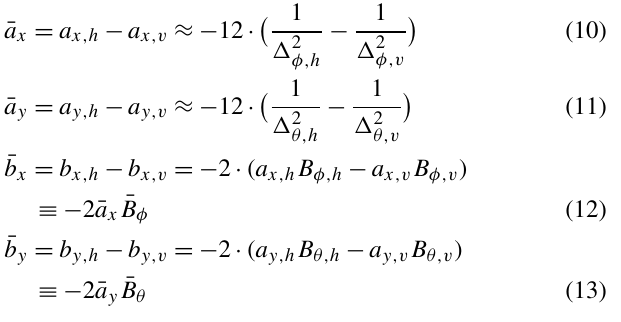
Z H − Z dr , and the procedure outlined above can be